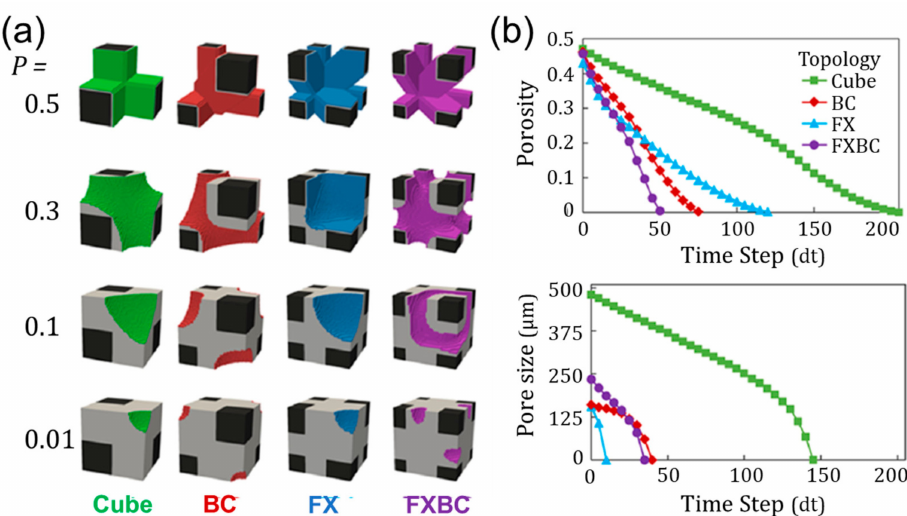
Figure 5. Tissue growth simulations ( a ) for unit cells with initial porosity P = 0.5 with plotted ( b ) changes in porosity and pore size for each time step. Images adapted with permission